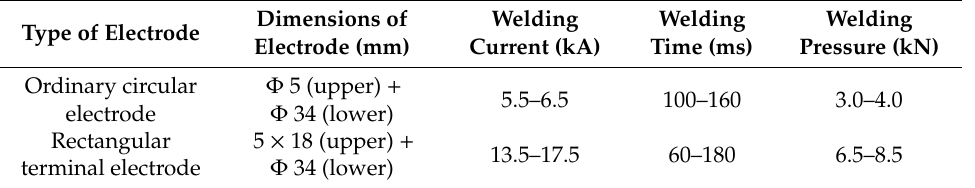
Table 3. Resistance spot welding (RSW) parameters for 0.9 mm thickness stainless steel